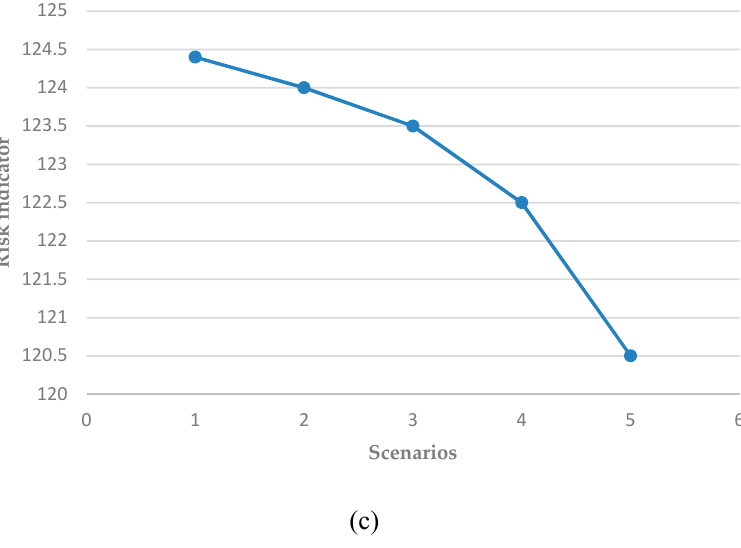
Figure 12. Scheduling results under different risk levels.